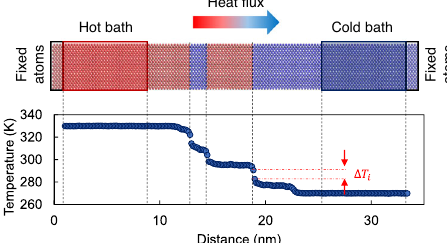
Fig. 5 Schematic of the NEMD simulation setup. The multilayer nanostructure (SL or RML) is sandwiched between two thermal baths. A layer of atoms is fi xed at each end to impose fi xed boundary conditions. The corresponding temperature pro fi le is also